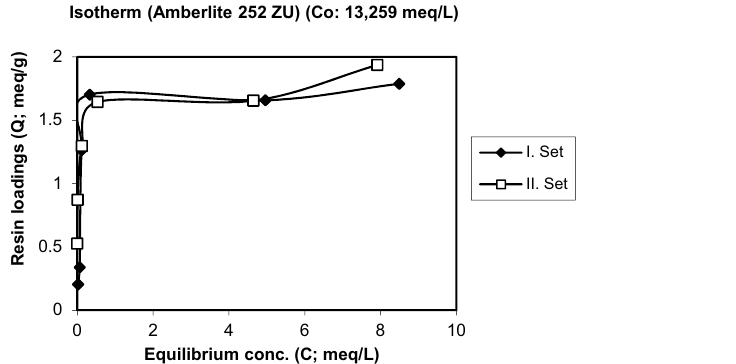
Figure 3. Isotherm of the uptake of Cr 3+ by the resin Amberlite 252 ZU (Initial conc. and pH: 13.259 meq/L, 3.15).